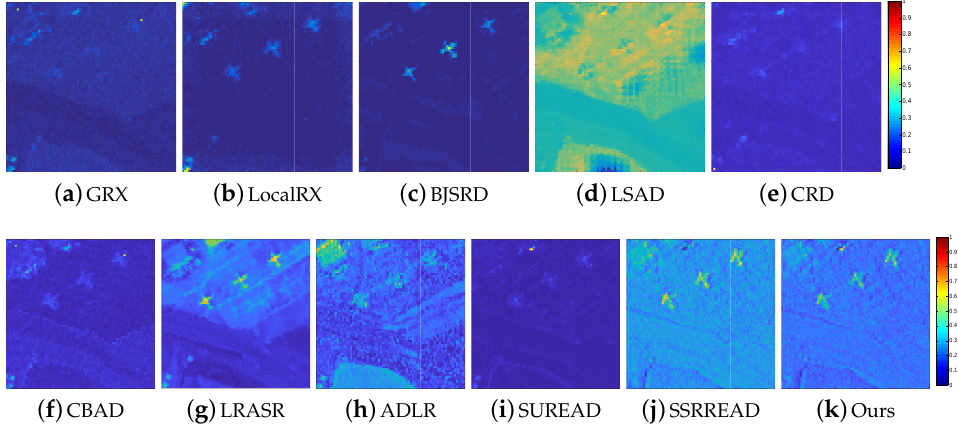
Figure 16. 2-D target probability color maps of the detection algorithms for the Sandiego80 dataset.